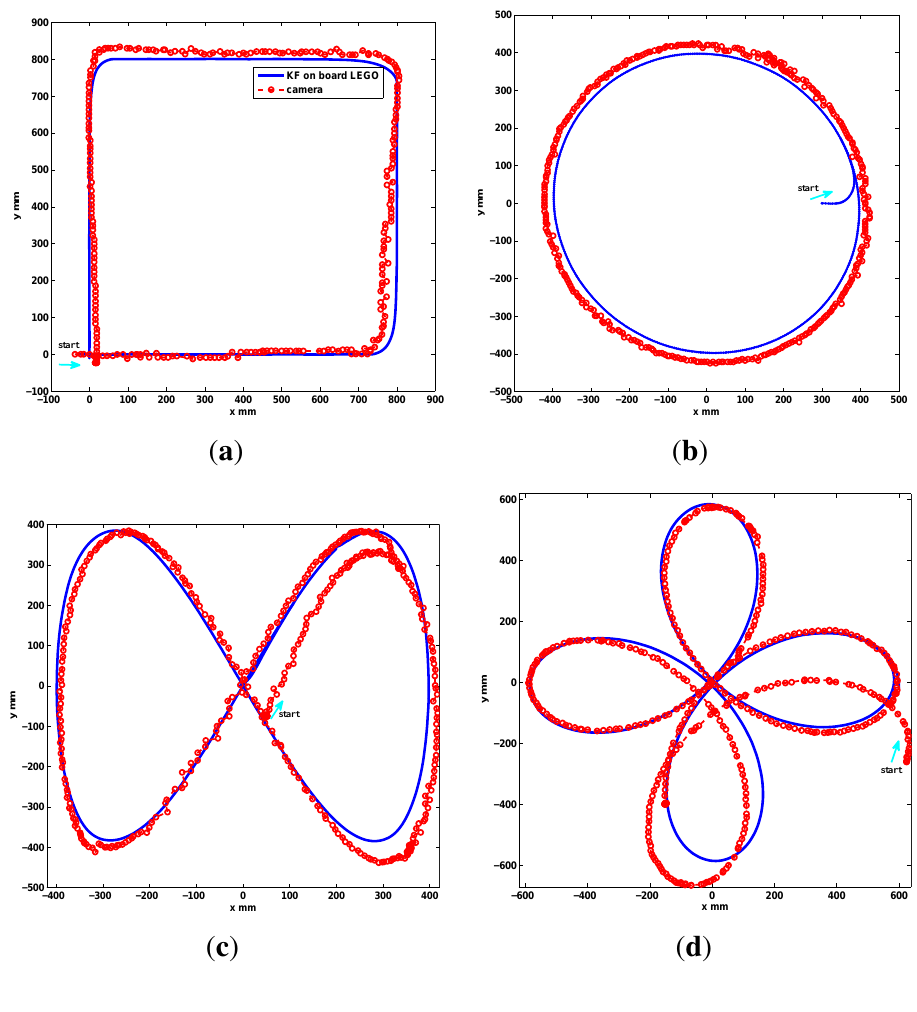
Figure 6. Implemented test, KF onboard the differential LEGO NXT. ( a ) Square; ( b ) Circle; ( c ) Lemniscate; ( d ) Polar